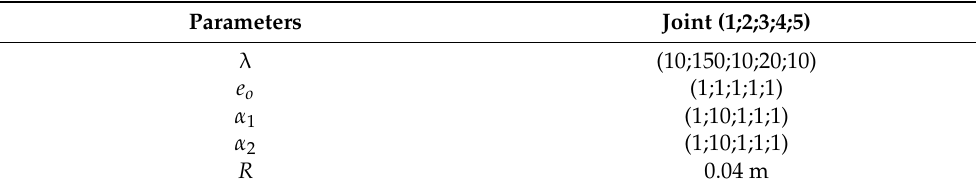
Figure 16. Point obstacle avoidance scenario. Table 1. Simulation parameters.